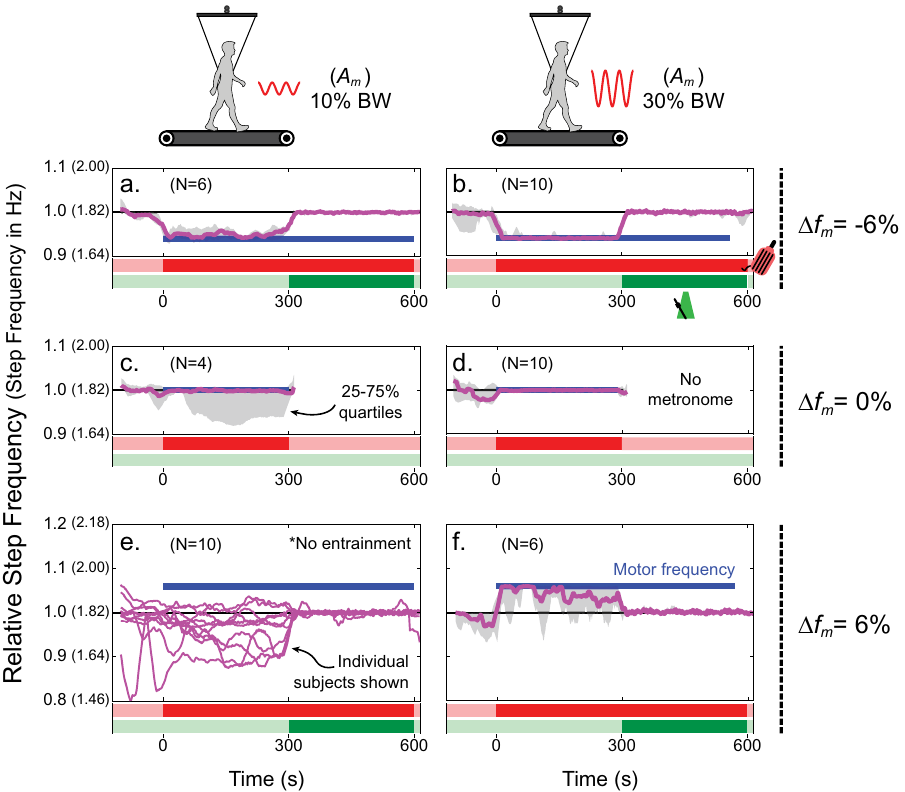
Figure 3. Entrainment results. The median relative step frequency ( f r , step frequency divided by preferred step frequency in Baseline 2; magenta) of all subjects who entrained (N) is plotted over each trial duration. Step frequency (in Hz) is shown for the average subject in parentheses. Twenty-five and 75% quartiles are used to indicate the distribution at every time point (grey shaded area). All trial conditions are shown, including: (cid:31) f m = − 6% in ( a ) and ( b ); (cid:31) f m = 0% in ( c ) and ( d ); (cid:31) f m = 6% in ( e ) and ( f ); A m = 10% BW in ( a ), ( c ) and ( e ); A m = 30% BW in ( b ), ( d ) and ( f ). The oscillations began at Time = 0 s and ended at approximately Time = 600 s . During 0 ≤ Time ≤ 300 s , subjects responded freely to the force oscillations. During 300 ≤ Time ≤ 600 s , subjects were directed to follow the cadence of the metronome at their predetermined baseline step frequency (“frequency clamping”) even as the oscillations continued at a different frequency. There was no metronome used in trials where (cid:31) f m = 0% , since frequencies were already matched. As a result, these experiments ended after around Time = 300 s . Note, median data are only shown for individuals who entrained at least once throughout the trial. In the trial condition where (cid:31) f m = 6% and A m = 10% BW , individual subject data are shown instead since no entrainment